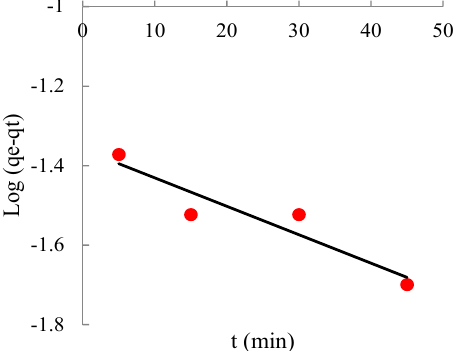
Fig. 13: First-order plot of cadmium adsorption onto polypyrrole/titanium dioxide nanocomposite.